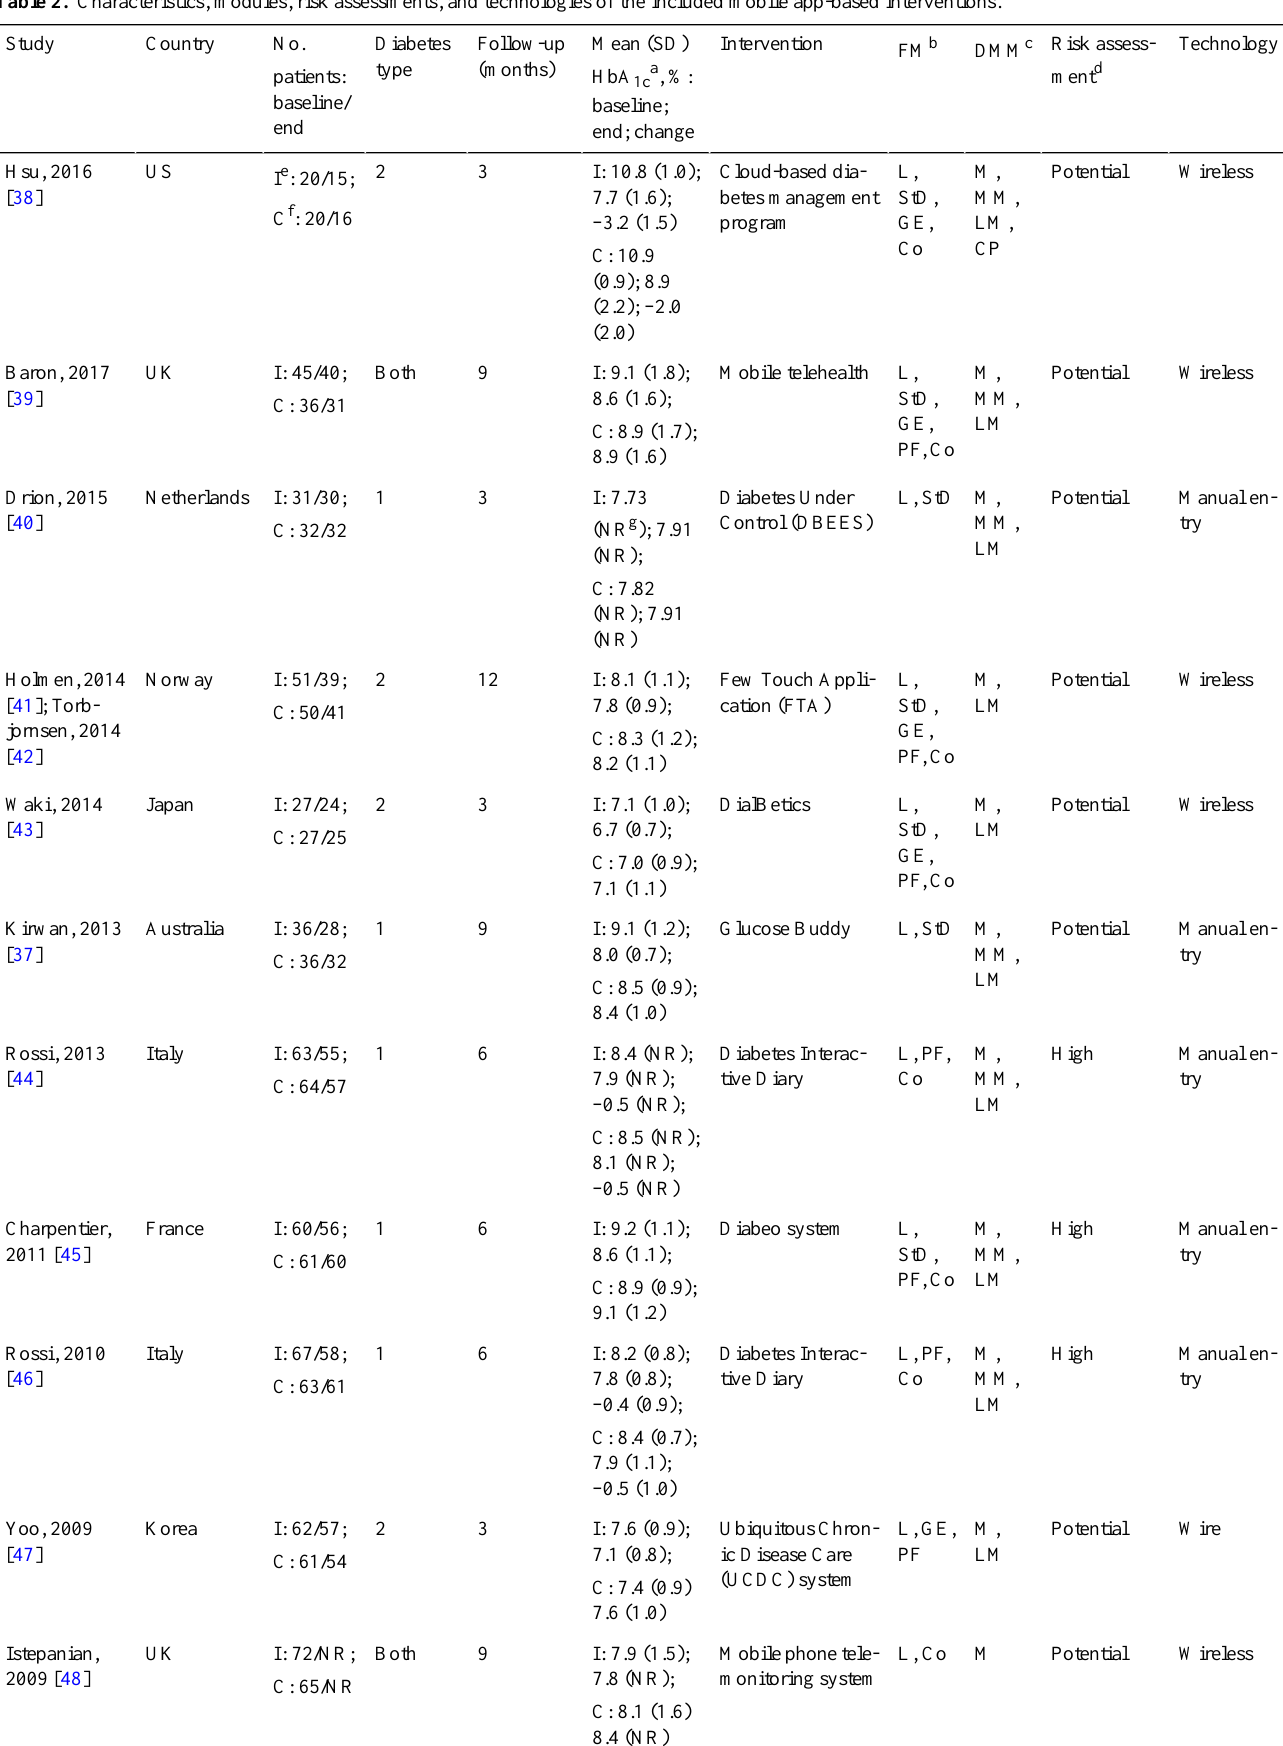
Table 2. Characteristics, modules, risk assessments, and technologies of the included mobile app-based